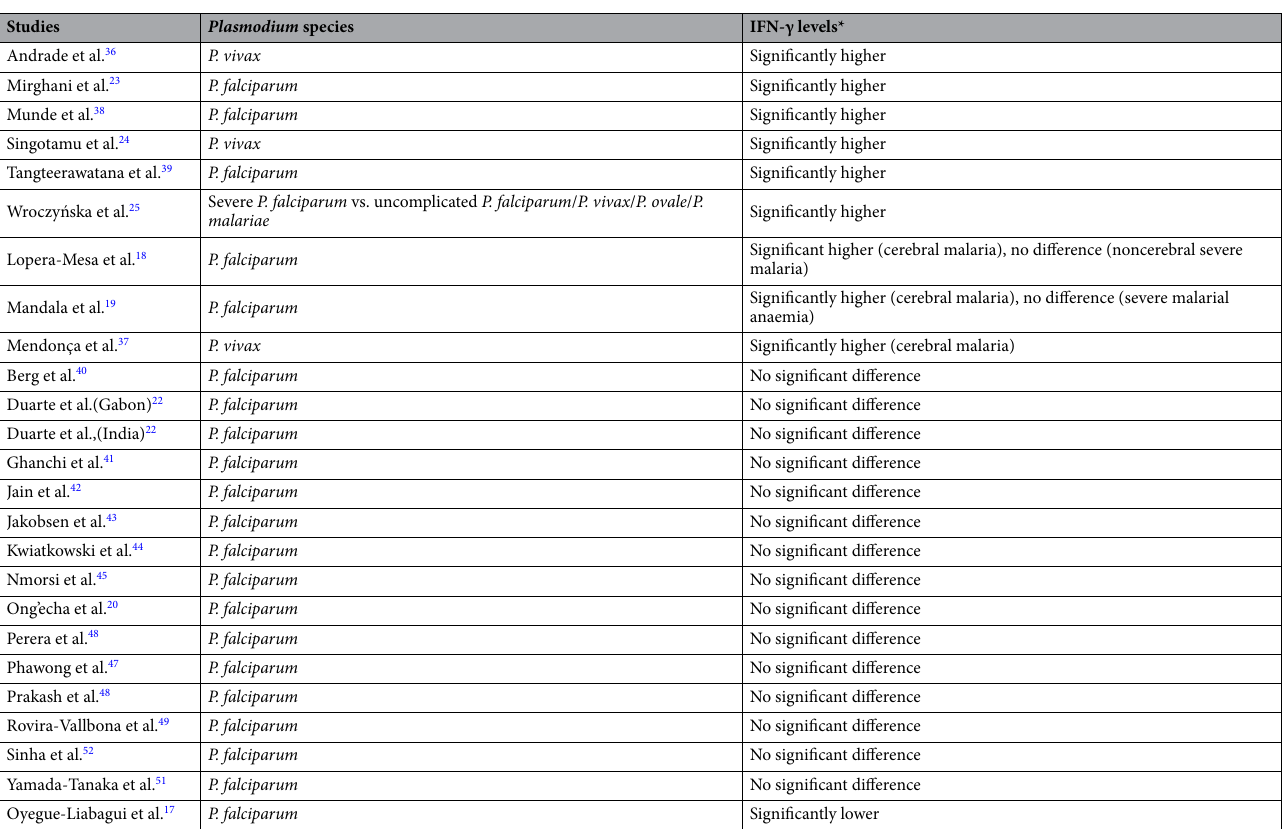
Table 2. Differences in IFN-γ levels between patients with severe and uncomplicated malaria based on qualitative data. *Results based on the statistical tests by included